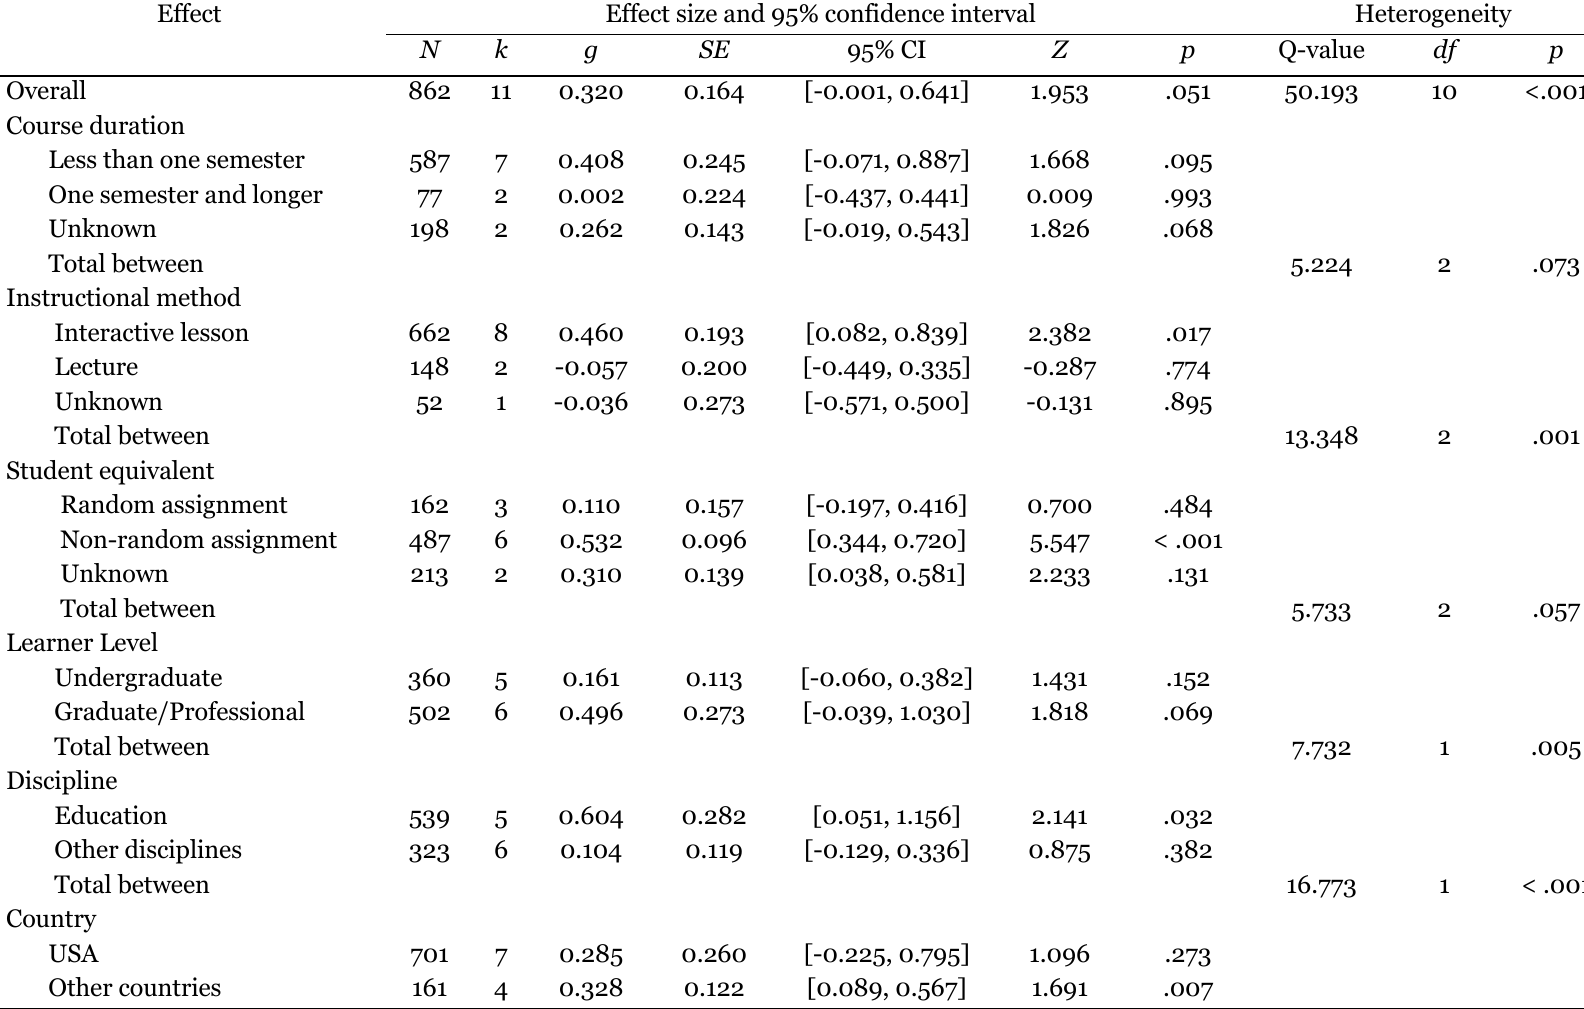
Table B Moderator Analyses (Synchronous vs. Asynchronous with Affective Outcomes)